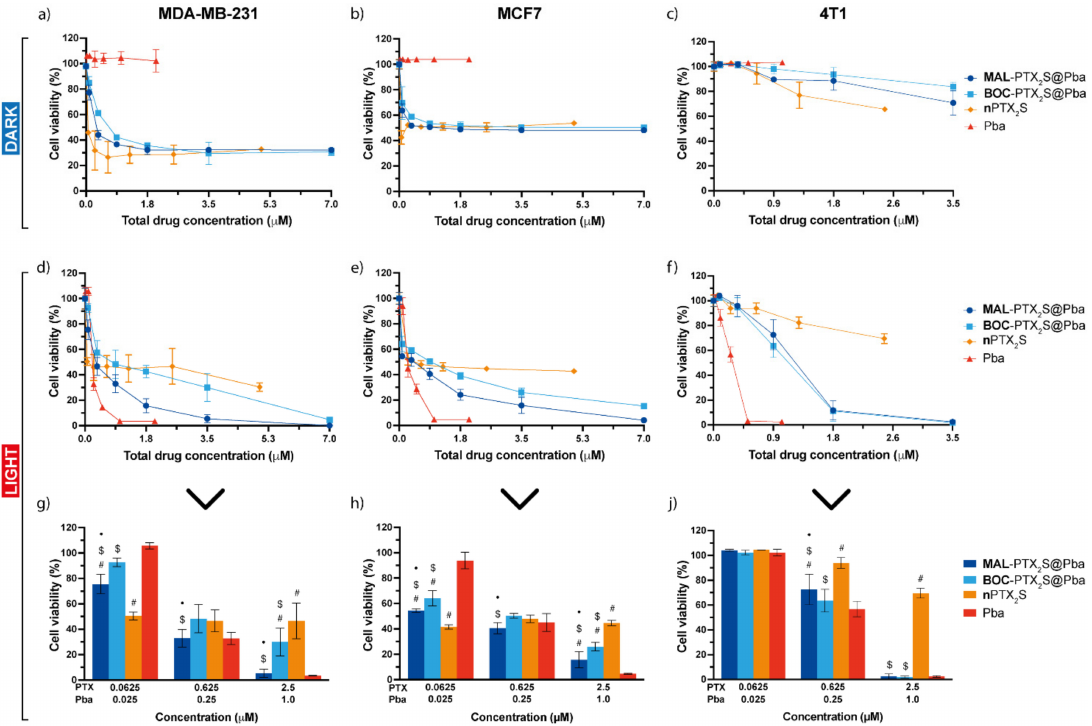
Figure 6. In vitro mono and combination therapy on cells cultured as monolayers. MDA-MB-231 ( a , d , g ), MCF7 ( b , e , h ) and 4T1 ( c , f , j ) cells were incubated for 24 h with the different drugs/drug combinations and maintained in the dark ( a – c ) or exposed to red light (1 J/cm 2 ) ( d – f ). Cell via- bility was assessed with the MTS assay after additional 24 (MDA-MB-231, MCF7) or 48 h (4T1) of cells release in drug-free medium. To better compare the cytotoxic effects after light exposure, some concentrations have been extrapolated from the dose-response curves: ( g ) for MDA-MB-231, ( h ) for MCF7, and ( j ) for 4T1 cells. Total drug concentration is referred to PTX + Pba concentration. Data are expressed as mean percentage ± SD of at least three independent experiments, carried out in triplicate. Statistical significance was calculated applying the ANOVA Two-way with Bonfer- roni’s correction: • significantly different from BOC -PTX 2 S@Pba; # significantly different from Pba; $ significantly different from n PTX 2